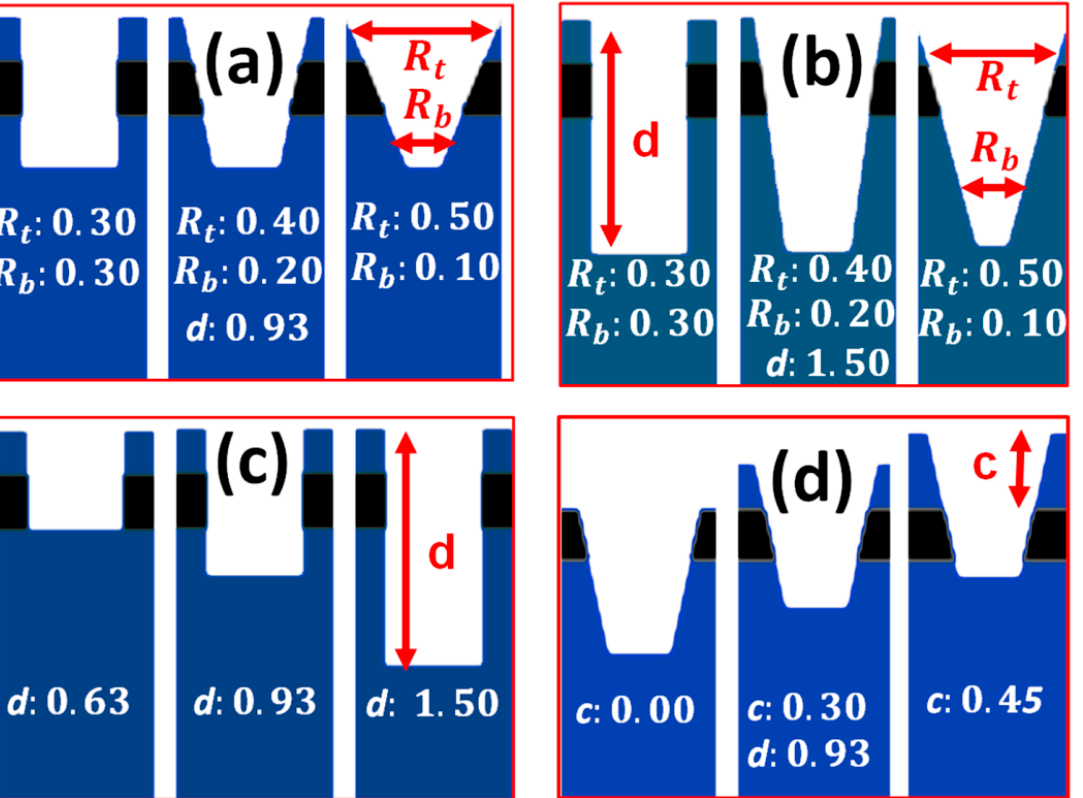
Figure 5. Different structural profiles of the PhC elements are considered for performance evaluation of the fabricated nanosensor device. ( a ) Variation in the shape of PhC elements with d = 0.93 a . ( b ) Variation in the shape of PhC elements for deeper holes with d = 1.50 a . ( c ) Variation in the depth of PhC elements for cylindrical hole shape. ( d ) Variation in the thickness of cladding layer for PhC element shape of R t / R b = 0.40/0.20 a at depth of d = 0.93 a